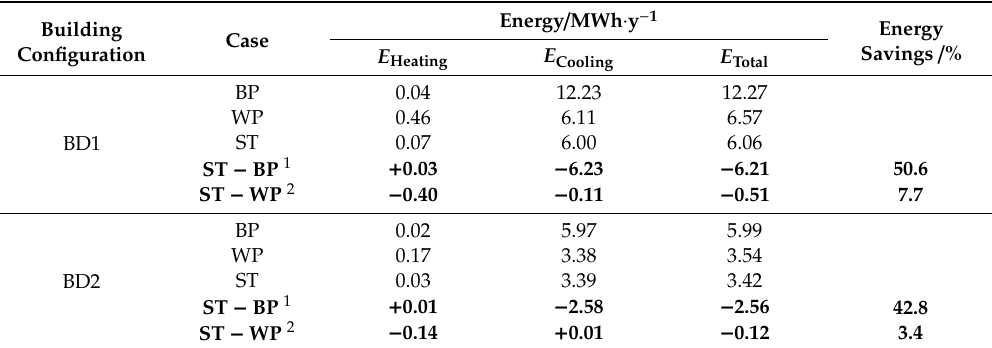
Table 8. Final energy demand for heating ( E Heating ), and cooling ( E Cooling ), total final energy demand ( E Total ), and energy savings over the year, for a building painted with an optimized thermochromic step transition paint (ST), located in Abu Dhabi, United Arab